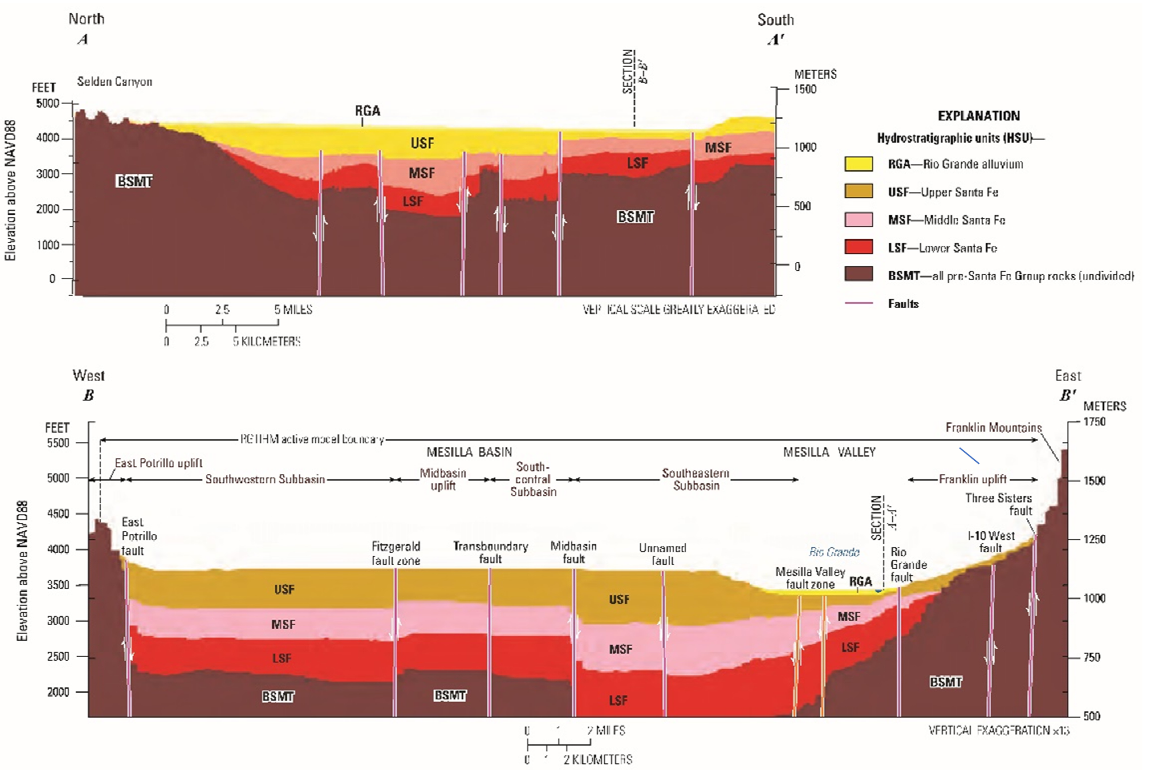
Figure 3. Cross sections showing the hydrostratigraphic units of the Mesilla/Conejos-Médanos Basin (adapted from [16]). Location of cross sections shown in Figure 2.